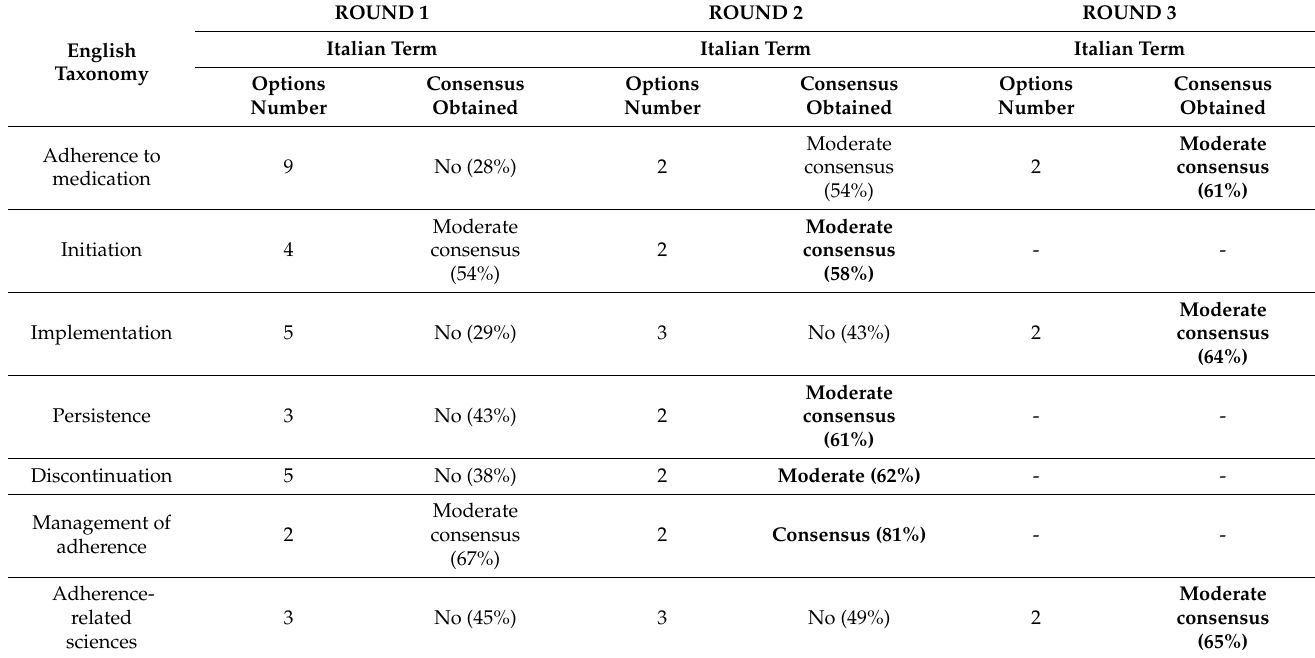
Figure 3. Professional field of the Italian-speaking experts in Rounds 1, 2, and 3. The Italian-speaking panelists reached a moderate consensus for all the terms and definitions reaching at least 50–75% of agreement. For the term and definition of “Manage- ment of adherence”, a higher consensus was reached (75–90% of agreement). Tables 1 and 2 show the consensus rate reached for the seven terms and definitions of the translations at each Delphi round, respectively. Table 1. Round needed for consensus reaching for Italian translation of